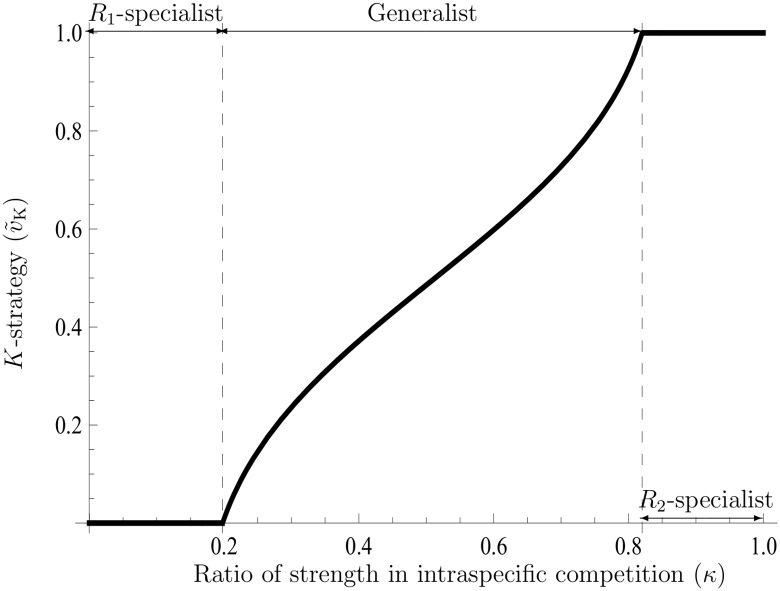
The K-strategy of the two-resource utilization model.This figure shows the shape of adaptive utilization under K-selection with respect to the ratio of the strength in the intraspecific competition κ. As the ratio increases, the adaptive strategy shifts to R1-specialists, generalists, and R2-specialists in turn. It is known that R2-specialists do not evolve in the absence of density effects [9]. The parameters are b1 = 0.15, b2 = 0.05, σ1 = 0.6, σ2 = 0.02, x = 0.01, x* = 1.5, ϕ(x*) = 10, and μ0 = 0.01.